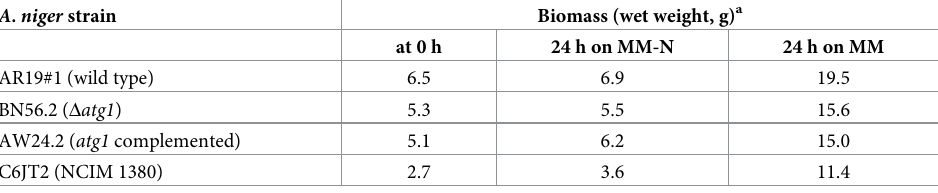
Table 2. Effect of nitrogen starvation on the biomass yield of A . niger